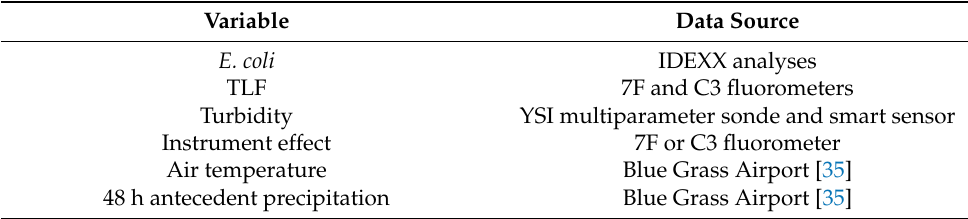
Table 1. Sources of data used in linear regression